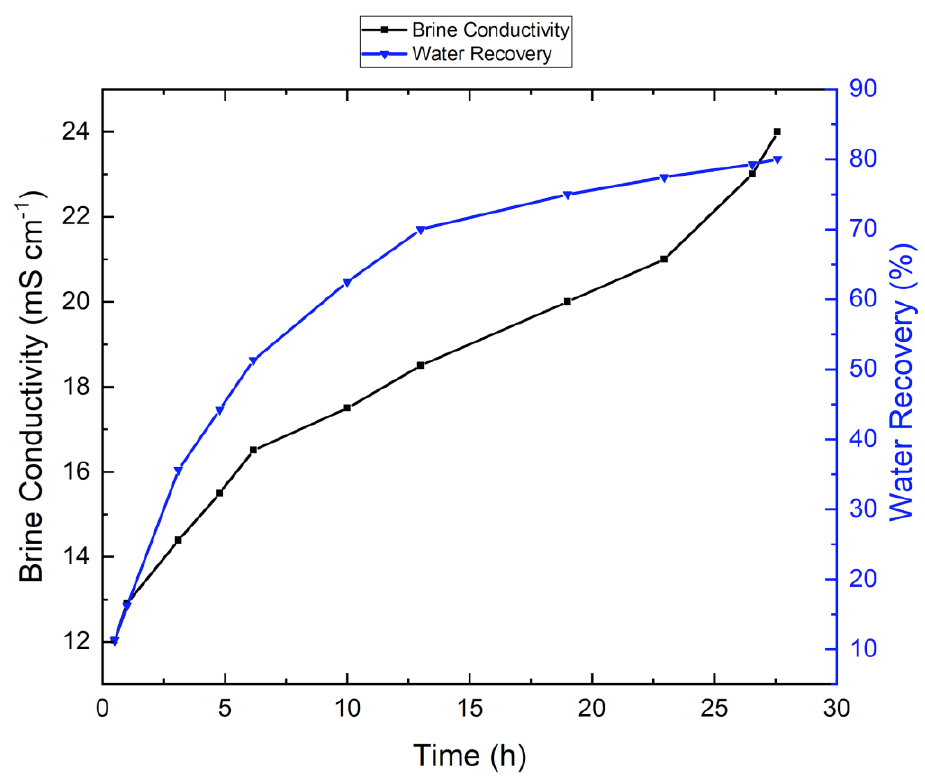
Figure A7. E ff ect of forced (i.e., high-pressure) wetting on system performance.